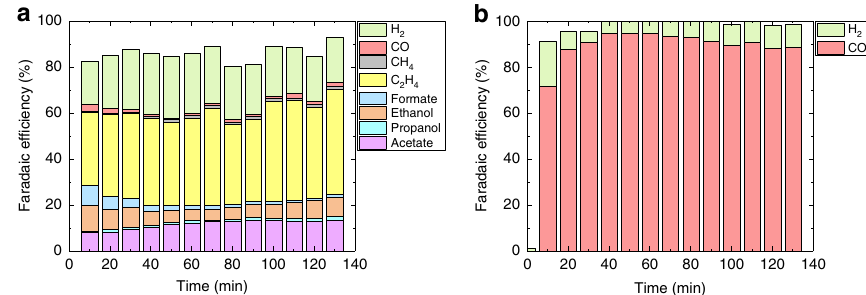
Fig. 5 Electrochemical conversion of CO 2 from oceanwater. Gas and liquid product distribution of converted CO 2 gas from oceanwater as a function of time using a Cu-catalyst-based and b Ag-catalyst-based vapor-fed CO 2